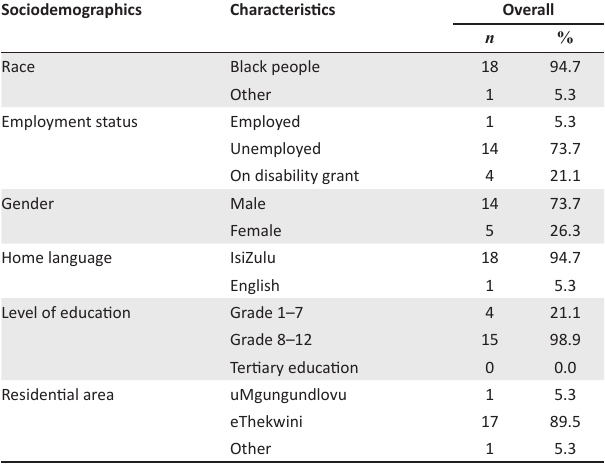
TABLE 1: Sociodemographic characteristics of mental health care users testing COVID-19 reverse transcription polymerase chain reaction positive ( N = 19) from a total of 207